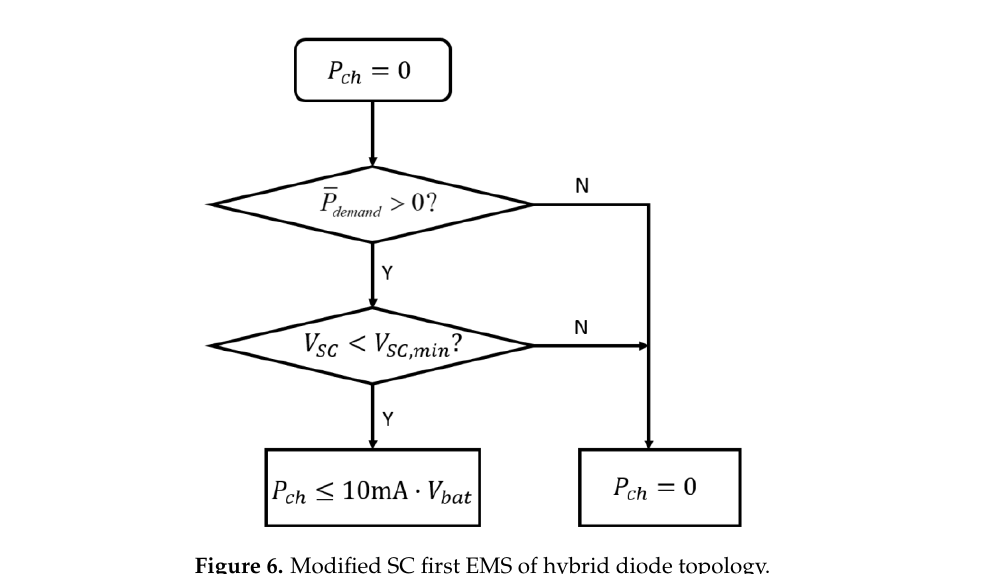
Figure 6. Modified SC first EMS of hybrid diode topology.